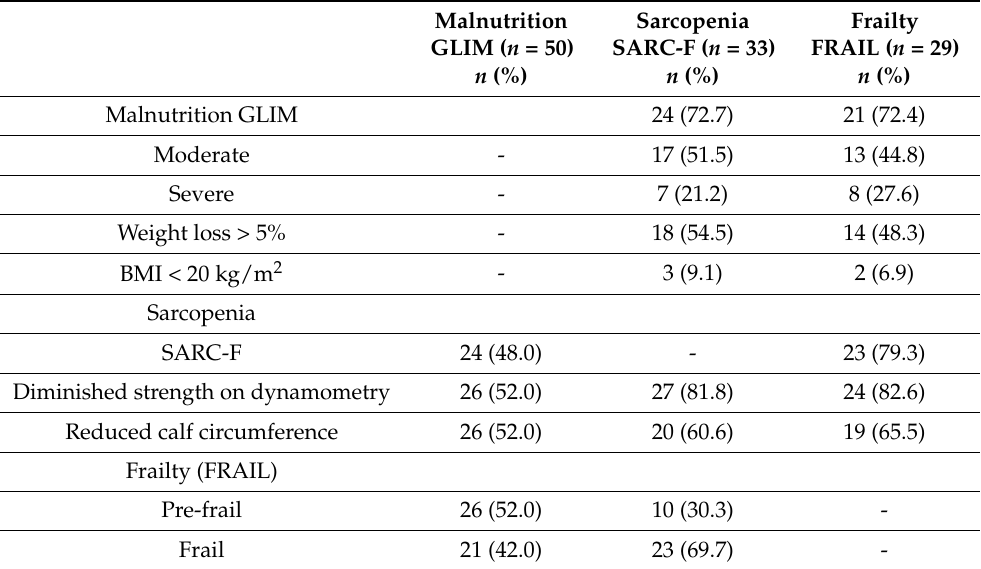
Diagnosis of malnutrition was according to GLIM 2019 criteria (Global Leadership Initiative of Malnutrition). Sarcopenia was diagnosed according to the SARC-F screening tool. Frailty categorization by FRAIL scale (Fatigue, Resistance, Ambulation, Illnesses, Loss of Weight). BMI: body mass index. Prevalence expressed as percentage ( n =